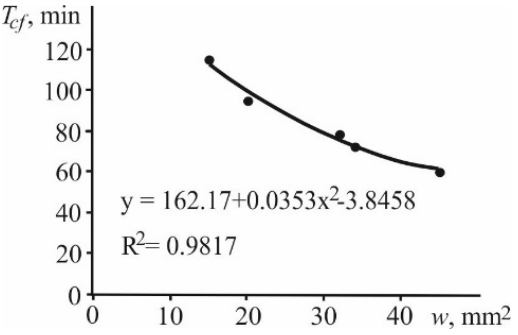
Figure 11. Change in the predicted time of failure T cf de– pending on the change in the area of blackout of the plate